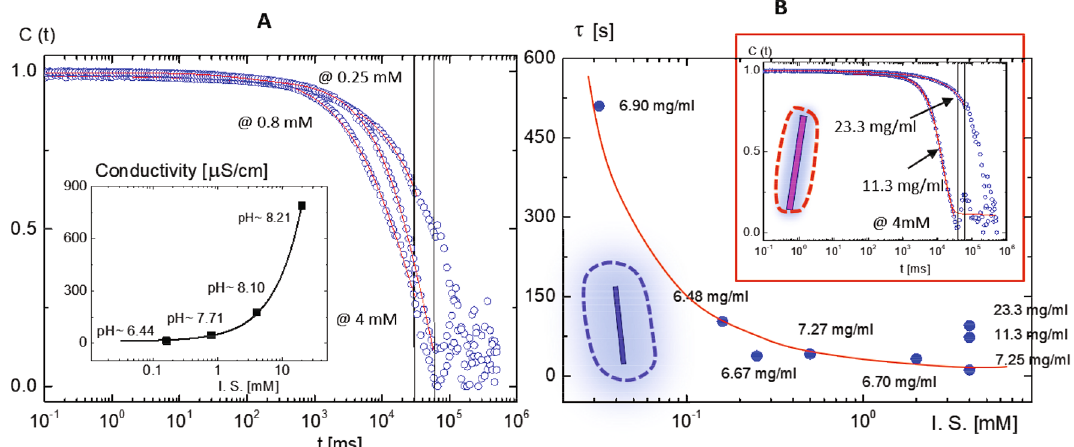
Figure 5. The microscopic relaxations of charged DNA virus (fd) suspensions at varying ionic strengths, measured by small-angle dynamic light scattering: ( A ) The comparison of normalized intensity auto-correlation functions of a fixed fd concentration (of 6.85 mg/ml) for different ionic strengths of 0.25 mM, 0.8 mM, and 4 mM salt. Here, the red lines are the best fit for the reliable data, avoiding the longer-term noise. The red arrow indicates a decrease of ionic strength as well as an increase of electric double layers surrounding the charged DNA rods. The inset shows the conductivity and pH value measured as a function of the ionic strength. Conductivity increases exponentially above 4 mM salt. ( B ) Microscopic relaxations, measured for different fd concentrations as a function of ionic strength: Much slower relaxation times are obtained below 1 mM for the similarly low concentration (for the average of 7 mg/ml). The inset in ( B ) is the comparison of normalized intensity auto-correlation functions for two high fd concentrations at a high ionic strength of 4 mM mg/ml).The relaxation time is increased as the ionic strength decreases, as indicated by the direction of the red arrow. The conductivity is substantially increased above the ionic strength of 0.8 mM at different ionic strengths in the inset of Fig. 5B, indicating that slower relaxation at higher ionic strength is directly influenced by the crowding effects of DNA rods. This then further explains the difference in phase behaviors in Fig. 2: Above the critical ionic strength (of 1–2 mM), the conducting current increases along the longer axis of the thin double layer of DNA virus rods. However, at lower ionic strengths below 1 mM salt, slower microscopic dynamics are dominant as a result of the perpendicular motions of charged DNA rods. This dramatic increase of microscopic relaxation time at the lowest ionic strength (of 0.032 mM salt) is also confirmed by the existing “soft-mode” of charged DNA virus rods, where the twist free energy contribution is coupled to the slower rotational diffusion of charged fd rods at the lowest ionic strength (of 0.032 mM salt) 17 . Self‑similarity of broken symmetries in 3D helicity and chiral‑nematic texture Since the DNA virus (fd rod) particles are intrinsically birefringent, their orientation textures are used as a direct measure of the concentration-dependent distinguishable orientations in bulk: Under the crossed polarizers, the light regions indicate more aligned phases of DNA rods in average orientations, while the black regions are isotropic states for their random orientations. Various optical morphologies are shown for a lower ionic strength (0.032 mM salt) in Fig. 6. Also, somewhat different optical contrasts of neighboring chiral-nematic domains are observed, depending on the low-ionic strength: At a lower ionic strength (of 0.032 mM), rather uniform color contrast is observed in the polarization of the chiral-nematic N* phase, as compared to two different hues (blue and green colors) of the N* phase at a higher ionic strength (of 0.16 mM). The comparison of depolarized optical morphologies of the N* phase and helical domains are seen in Fig. 6A–C respectively. The reason for such delicate optical contrasts of depolarized morphologies is related to the optical path for transmitted light passing through the 3D bulk orientation textures. It shows that higher contrast appears at an ionic strength of 0.16–0.8 mM salt, where the structural glasses are found in the phase diagram. This suggests that the role of domain boundaries cannot be negligible even for minor difference in the orientations of neighboring chiral-nematic and N-star (N*) orientation textures, which will be discussed in the following section. The details of self-similarity with depolarized optical morphology are provided for a chiral-nematic phase and the localized (positive I + , and negative I − ) views in 3D intensity maps in Fig. 6D,E, obtained by the ImageJ software. Depolarized morphologies of tightly packed helical domains are also shown in Fig. 6F–I, with the various types of defect lines. These 3D intensity maps visualize directly the orientation textures formed in bulk elastic deformations. Here, the intensity maps are of use in distinguishing both-side (top/bottom) substrates and for reading the actual intensity pixel values in region of interests (ROIs): For instance, the black disclination lines are clearly depicted as the backbones in negative ( I − ) intensity maps of the depolarized morphology. In the positive ( I + ) 3D intensity maps, the spatial gradients are captured clearly in the individual bright fingerprint (or stripe) textures among the neighboring ones of intensity profiles. Similar trends of intensity maps are shown for the smaller pitch length (~ 100 µm) in helical domains, and likewise larger pitch lengths (~ 100–200 µm) of chiral-nematic textures are shown as the replica in different length scales.